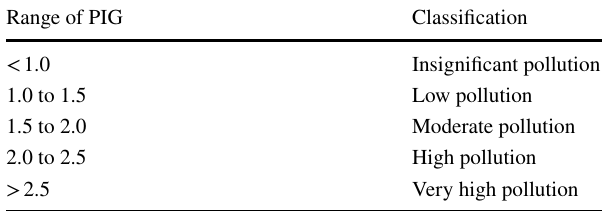
Table 2 Classification of pollution index of groundwater (PIG). Source : Subba Rao (2012) Range of